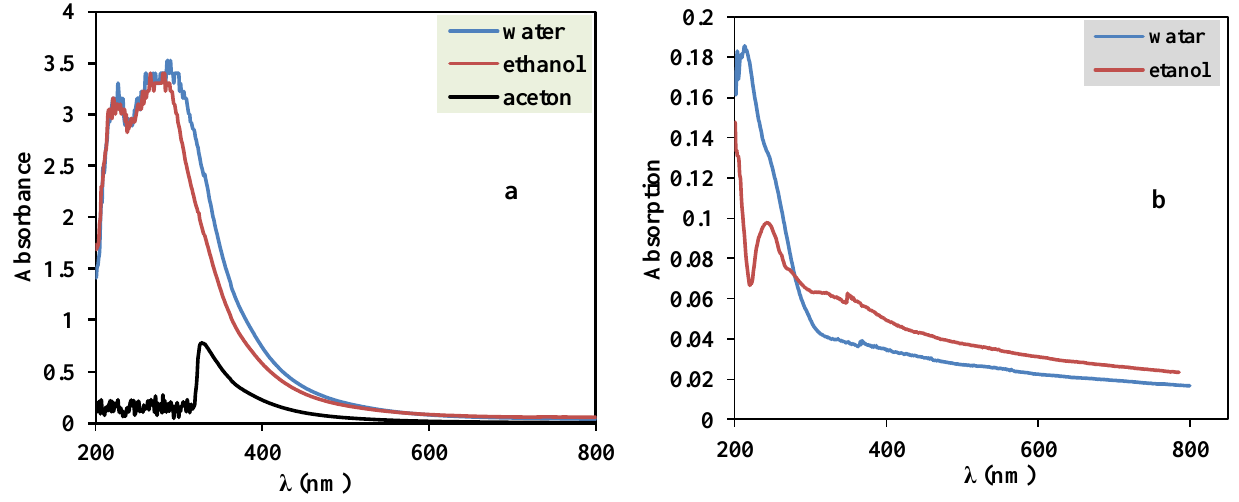
Figure 3: absorption spectra of lithium-niobate suspension (a) LN pellet, (b) LN